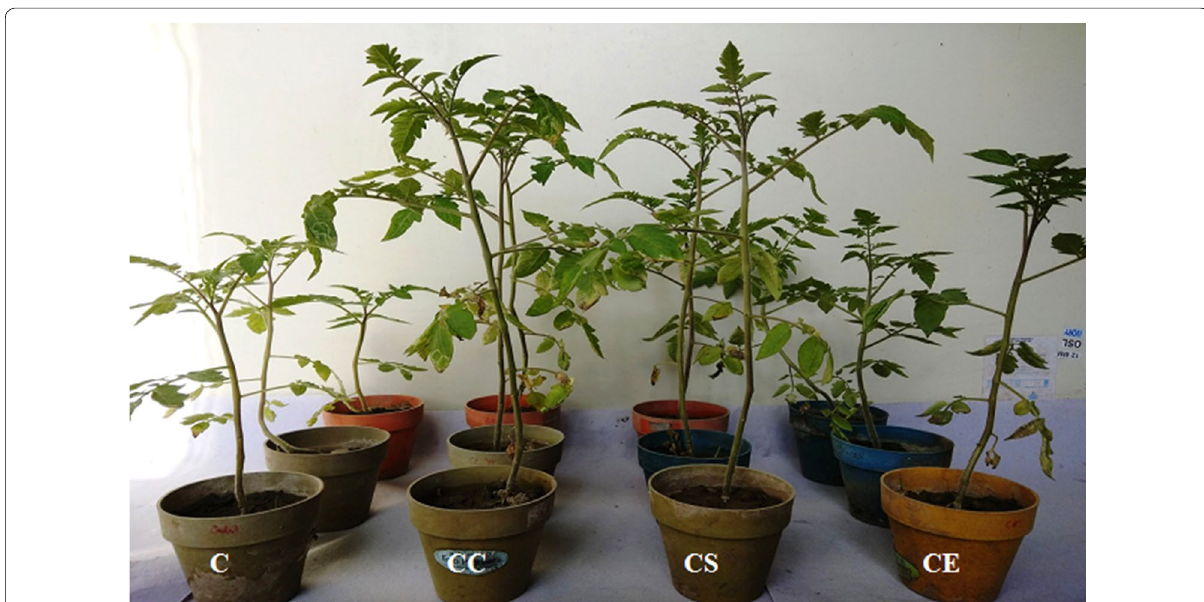
Fig. 8 Plant growth promoting potential of Streptomyces sp. MR14 and its metabolites on growth of S. lycopersicum (tomato) plants; C (untreated plants, water only), CC (plants treated with culture cells only), CS (plants treated with culture supernatant only) and CE (plants treated with culture extract of strain MR14 only)